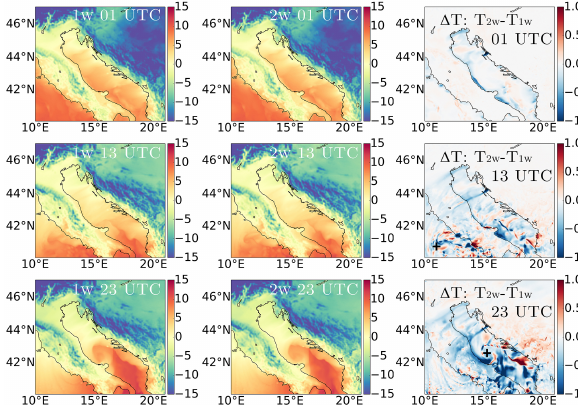
Figure 9. ALADIN 10m temperatures [ ◦ C] in ALADIN1w (left column) and ALADIN2w (middle column) on 10 February 2012 at: 01:00UTC (top row), 13:00UTC (middle row) and 23:00UTC (bottom row). Right column depicts temperature differences [ ◦ C] in both setups. Black + signs in middle and bottom panels of the right column indicate the approximate location of the center of the low pressure area at 13:00UTC (middle panel) and 23:00UTC (bottom